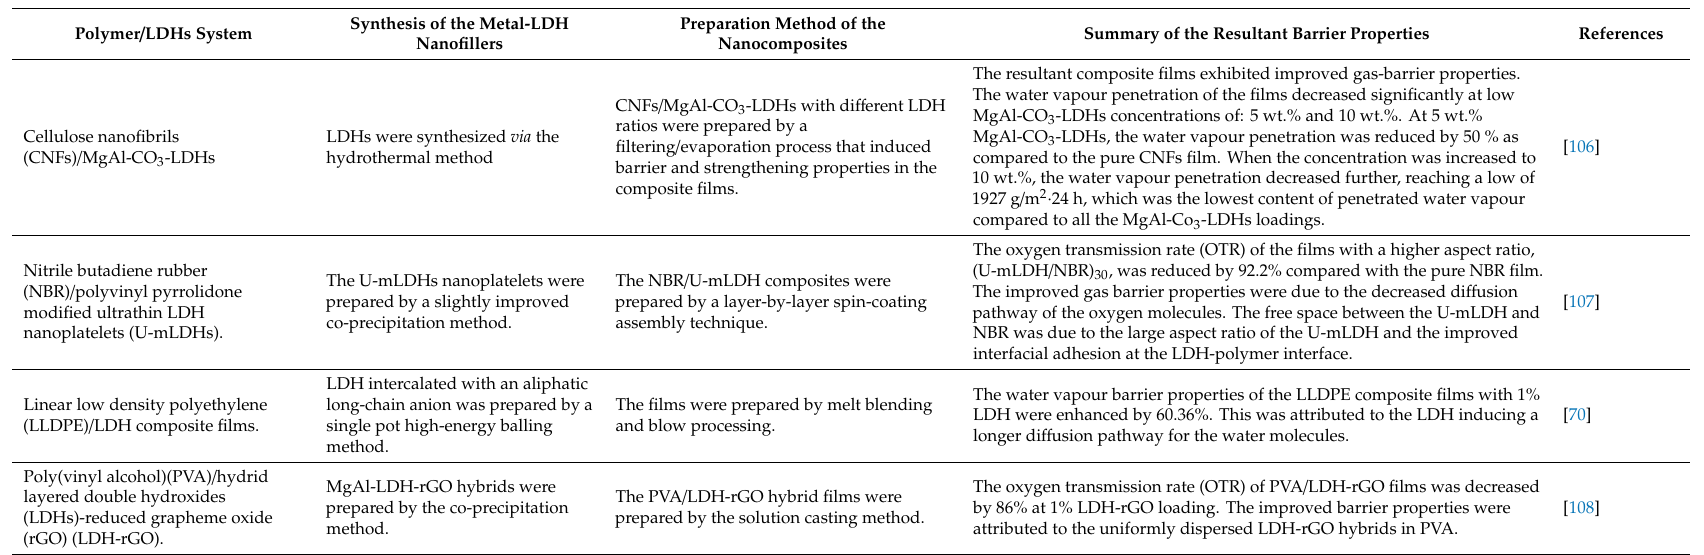
Table 4. Selective studies for the preparation and barrier properties of polymer-LDHs